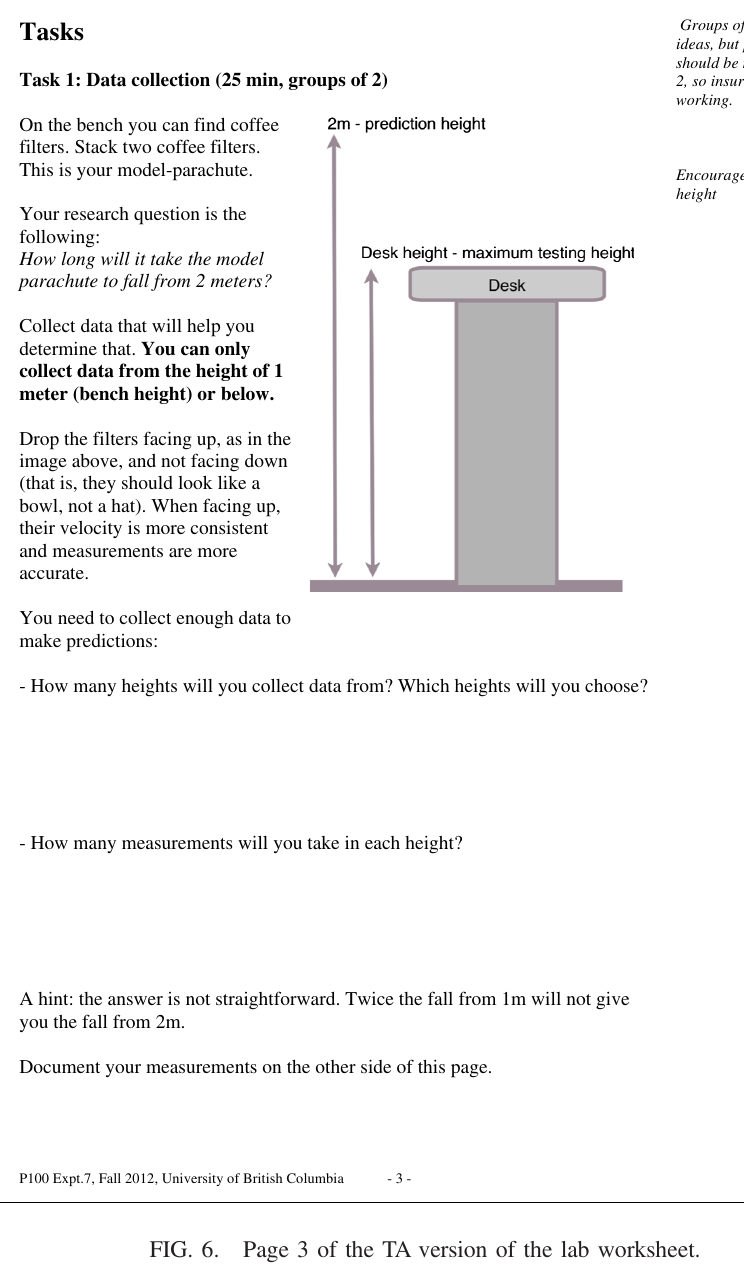
FIG. 6. Page 3 of the TA version of the lab